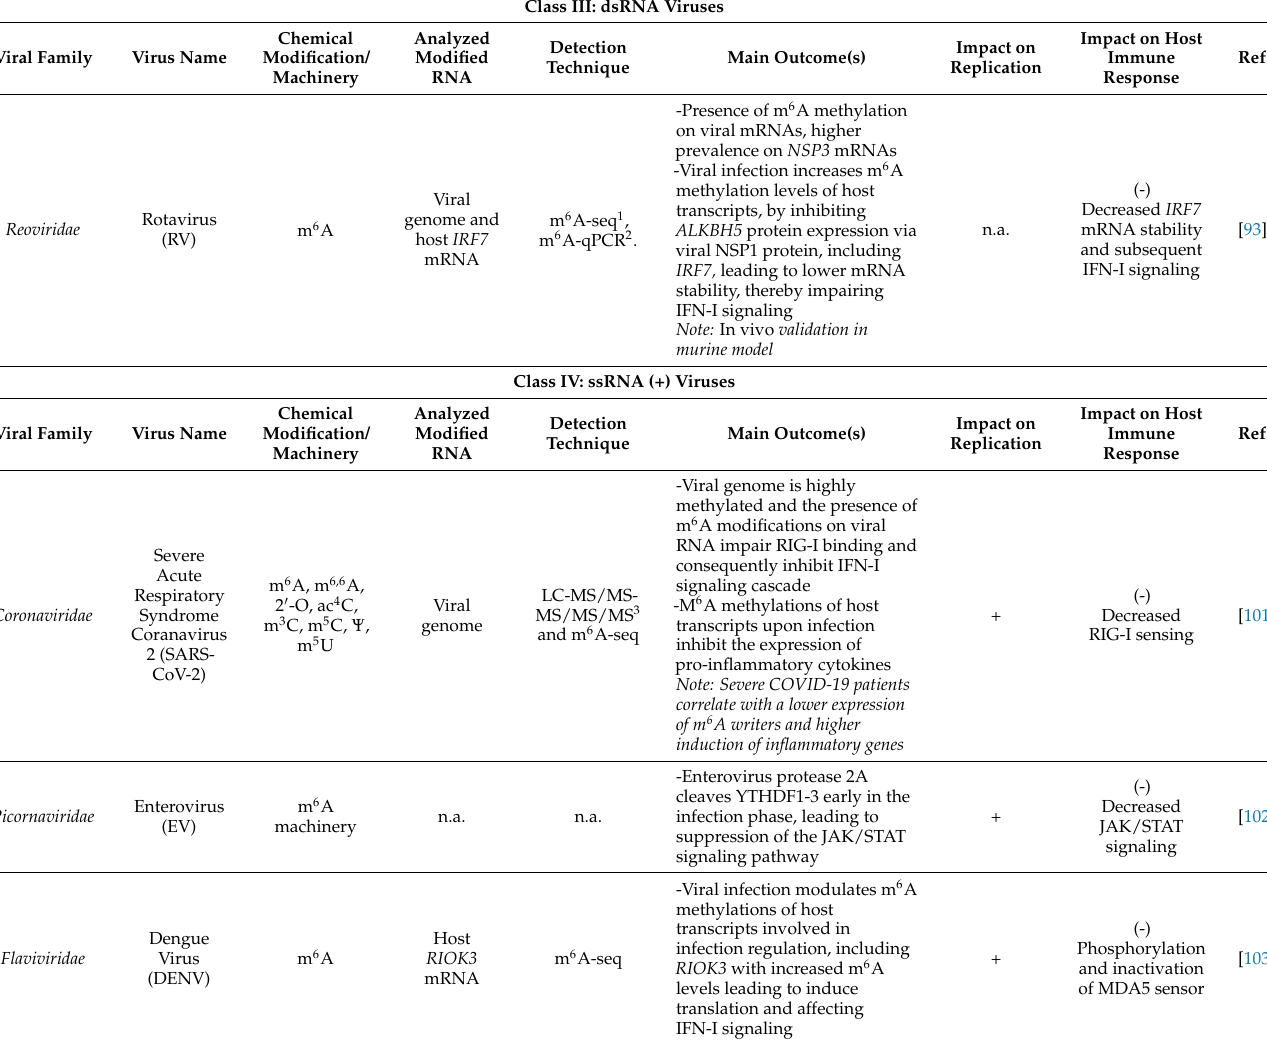
Table 1. Listofstudiesshowingtheimpactofvirusesonhostimmuneresponsethroughepitranscriptomics. Class III: dsRNA